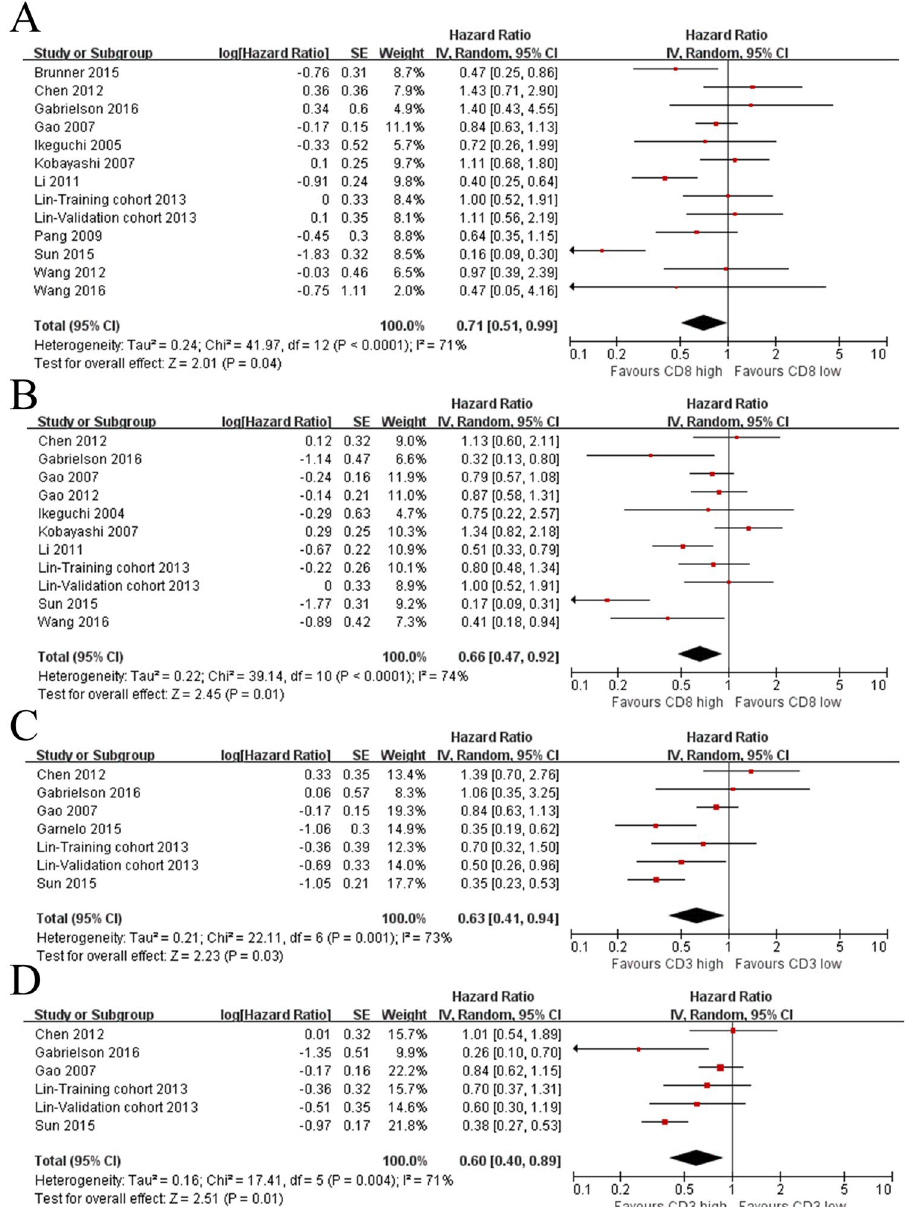
CD3 + T lymphocytes on OS. ( D ) The effect of